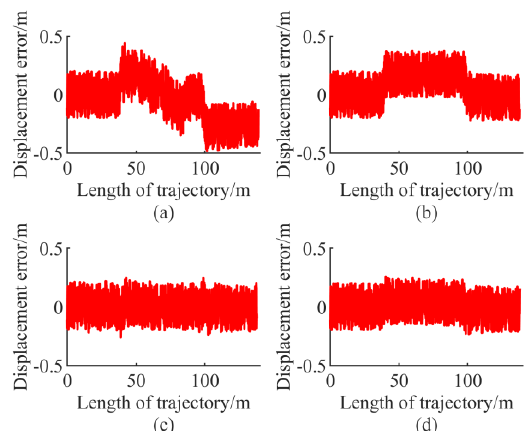
Figure 41. The heading angle speed of the final set of comparison. ( a ) LMPC. ( b ) LEMPC. ( c ) NMPC. ( d ) NEMPC.